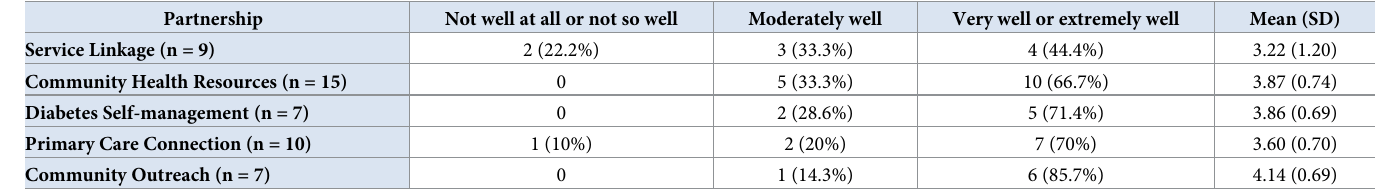
Table 6. Partnership-level assessment of the extent to which the goal of developing a meaningful partnership has been achieved. Partnership Not well at all or not so well Moderately well Very well or extremely well Mean (SD) Service Linkage (n = 9) 2 (22.2%)